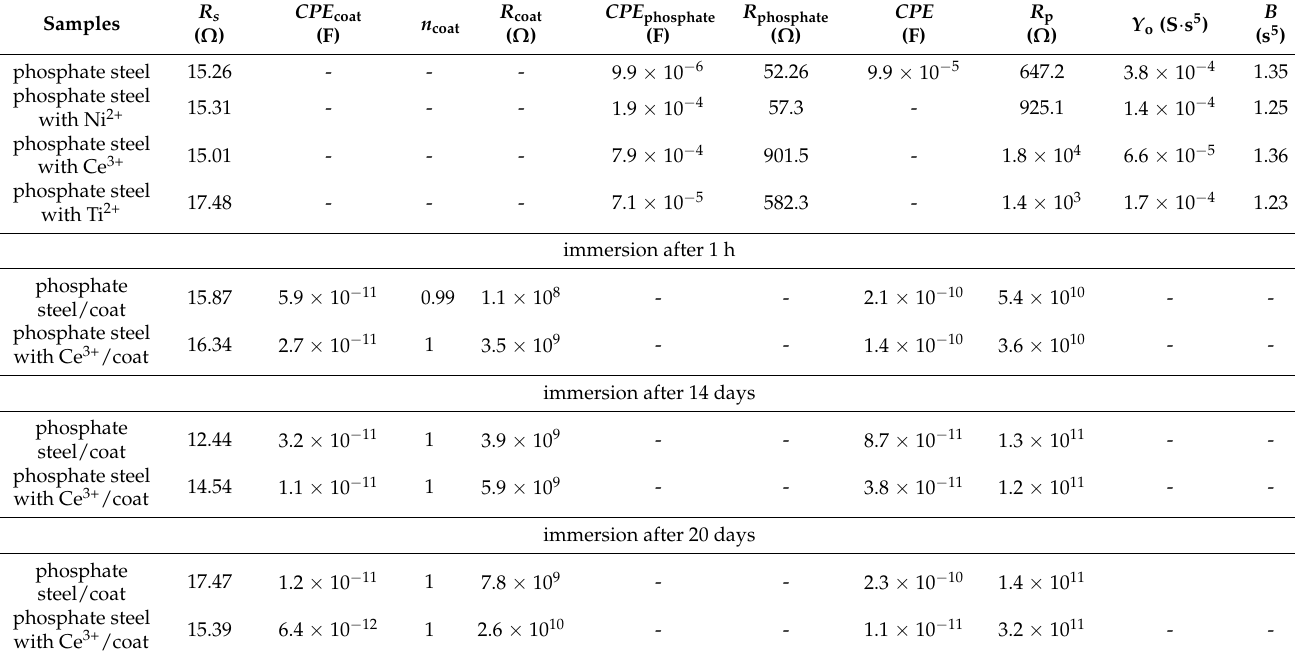
Table 11. The results of the EIS measurement on phosphate steel surface and phosphate steel surface modified with Ni 2+ , Ce 3+ , and Ti 2+ ions immediately after different pre-treatment processes immersion in 3.5 wt.% NaCl solution. The table contains the results of EIS measurements for the same samples but with three types of coating respectively after 1-h, 14 and 20 day immersion in 3.5 wt.% NaCl